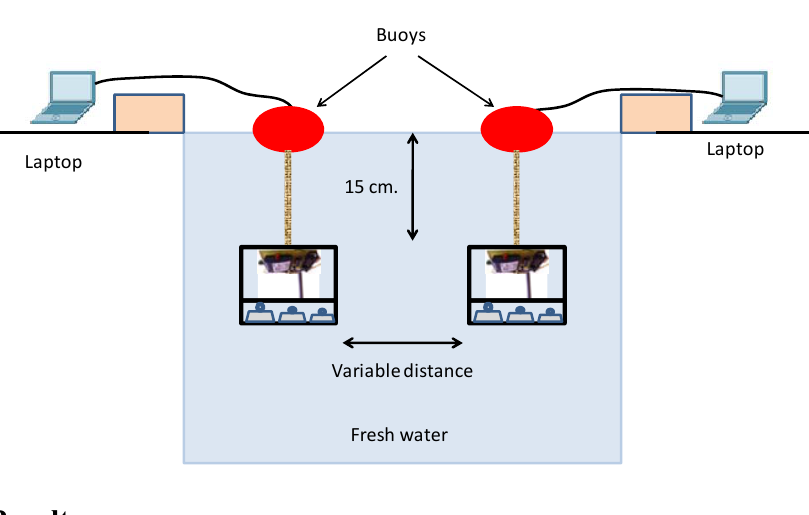
Figure 4. Topology used to take